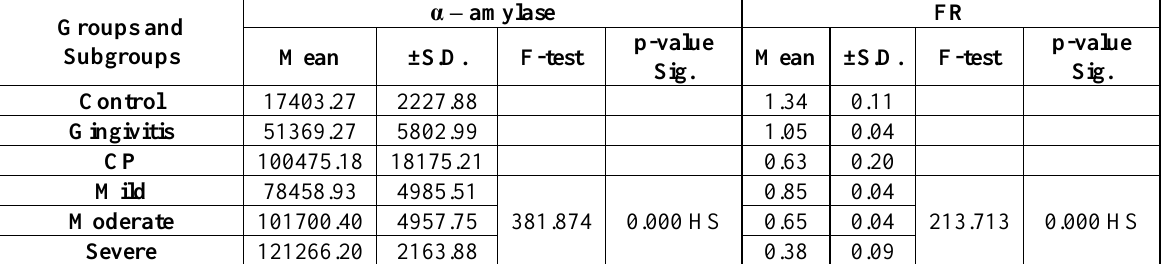
Table 3: Descriptive statistics of salivary α– Amylase concentrations (U ̸ L) and FR (ml/min) for groups and subgroups with difference among CP subgroups